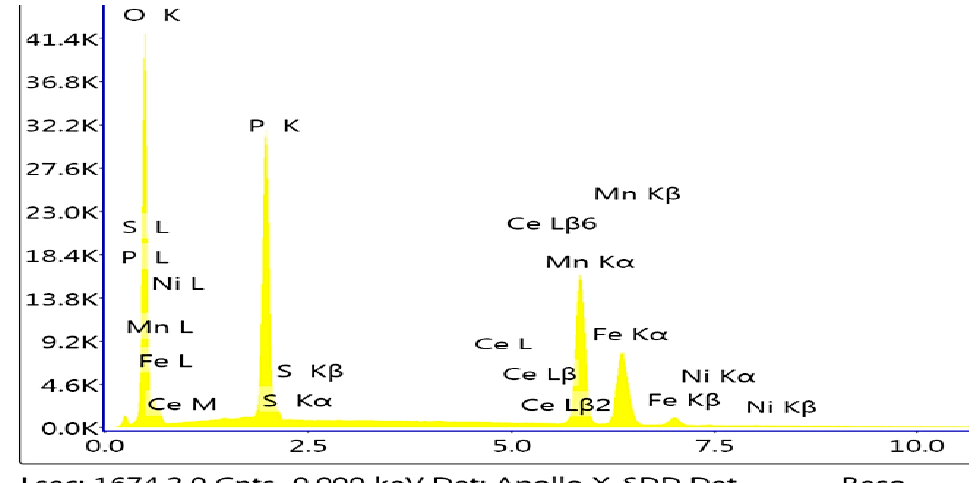
Figure 19. EDS spectrum of the sample modified with cerium.